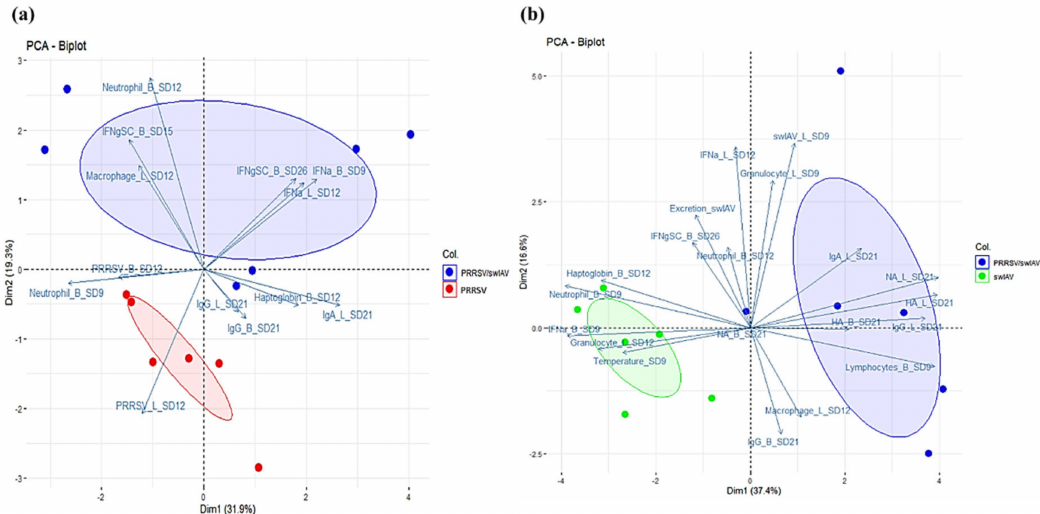
Figure 7. Principal component analysis (PCA) of the experimental variables of co-infected and single-infected pigs. ( a ) PCA biplot of PRRSV/swIAV and PRRSV pigs (13 factors). ( b ) PCA biplot of PRRSV/swIAV and swIAV pigs (20 factors). L: lungs; B: blood; SD: study day; PRRSV: PRRSV genomic load; swIAV: swIAV genomic load; HA: anti-HA antibodies; NA: swIAV-neutralizing antibodies. IFNgSC: CMI. Dim 1 is the axis representing the highest percentage of variance and Dim 2 represents the second axis. Each color dot (PRRSV/swIAV: blue, PRRSV: red or swIAV: green) represents the projection on the PCA of each pig. The ellipses depict the spread of the PCA data for PRRSV/swIAV, PRRSV or swIAV